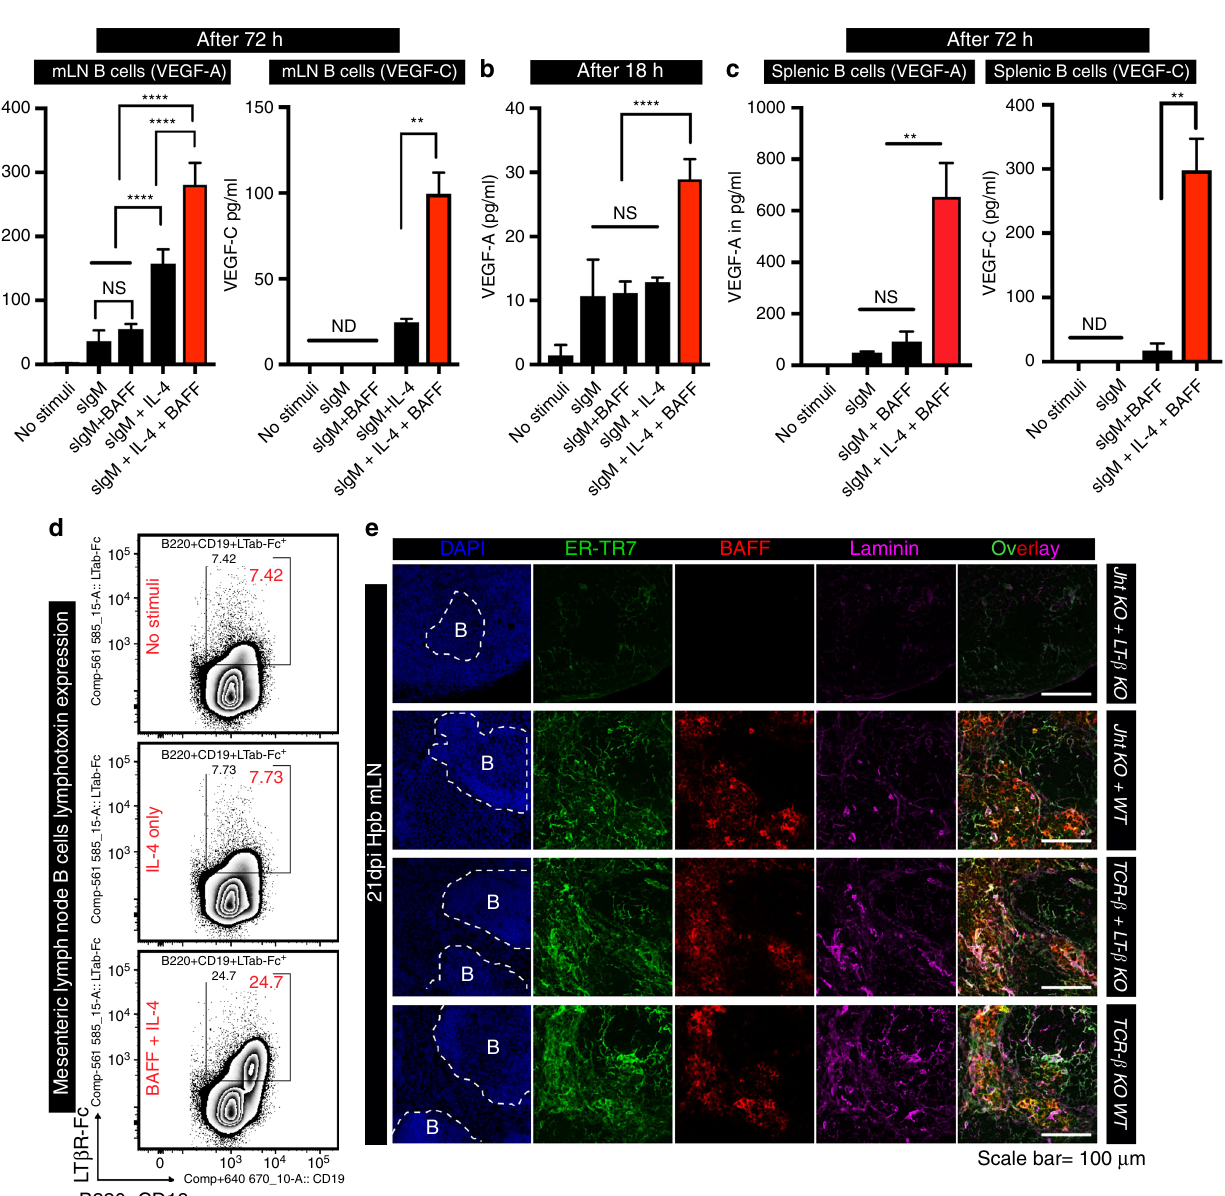
Fig. 6 BAFF and IL-4 stimulation of B cells promotes lymphotoxin and VEGFs production. a – c mLN B cells were cultured with anti-IgM with or without IL-4 ± BAFF and the culture supernatant collected at a 72 h or b 18 h post stimulation for quantitation of VEGF-A and VEGF-C by ELISA. c Splenic B cells were stimulated as in ( a ) and the culture supernatant collected at 72 h for quantitation of VEGF-A and VEGF-C by ELISA. Data represent mean ± SEM, and are representative of pooled data from three independent experiments a or are representative of two independent experiments b , c . d Naive mLN B cells were cultured with or without IL-4 ± BAFF for 18 h then B-cell lymphotoxin expression determined by staining with LT β R-Fc. Data represent mean ± SEM and representative of three independent experiments. e mLN cryosections from mixed BMC-lacking lymphotoxin on B or T cells and infected with Hp for 21 days were stained for BAFF + ( red ) and FRCs (ER-TR7 + Laminin + ). Scale bar = 100 μ m. Statistical analyses were performed using ANOVA, Bonferroni ’ s multiple comparison test and signi fi cance donated as * P < 0.05, ** P < 0.01, *** P < 0.001, **** P < 0.0001; NS not signi fi cant and ND not